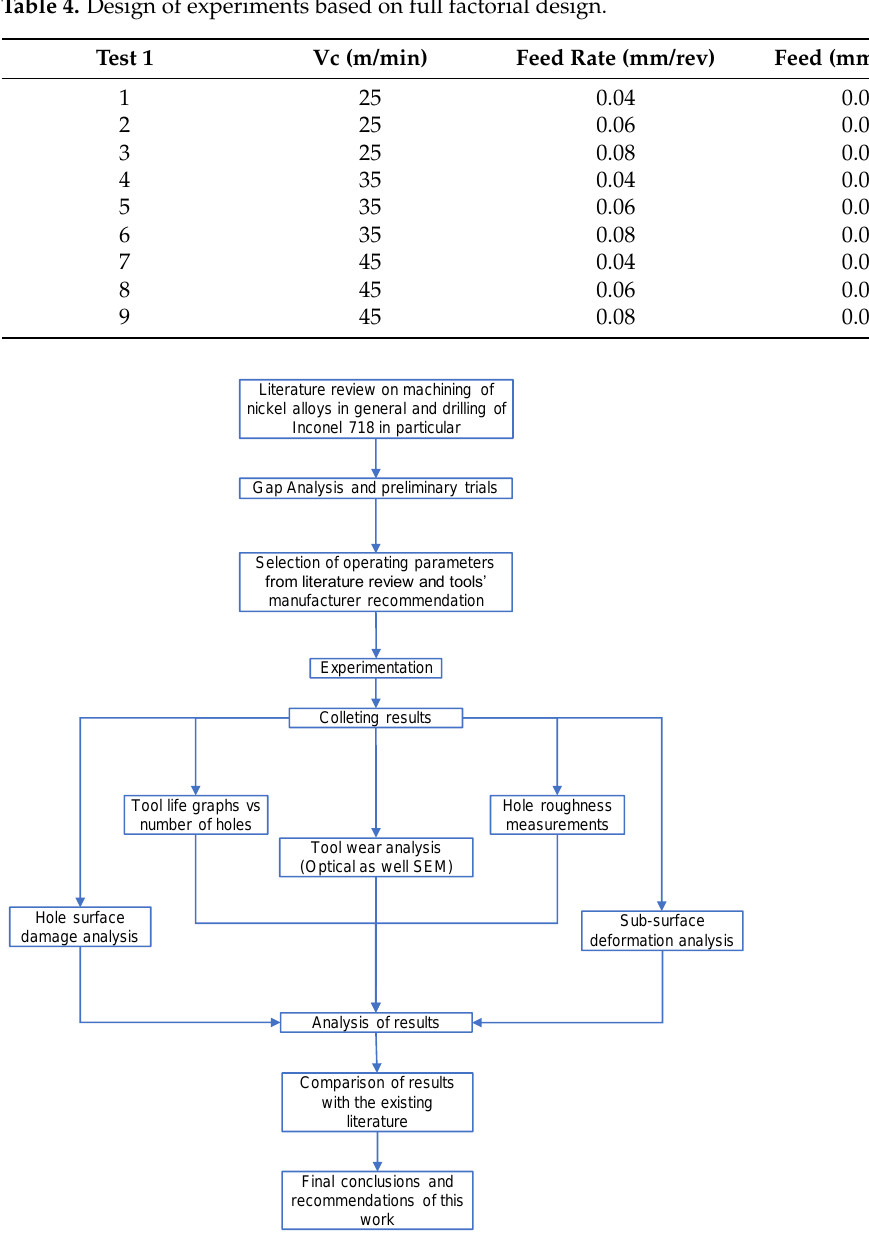
Figure 5. Research methodology framework used.